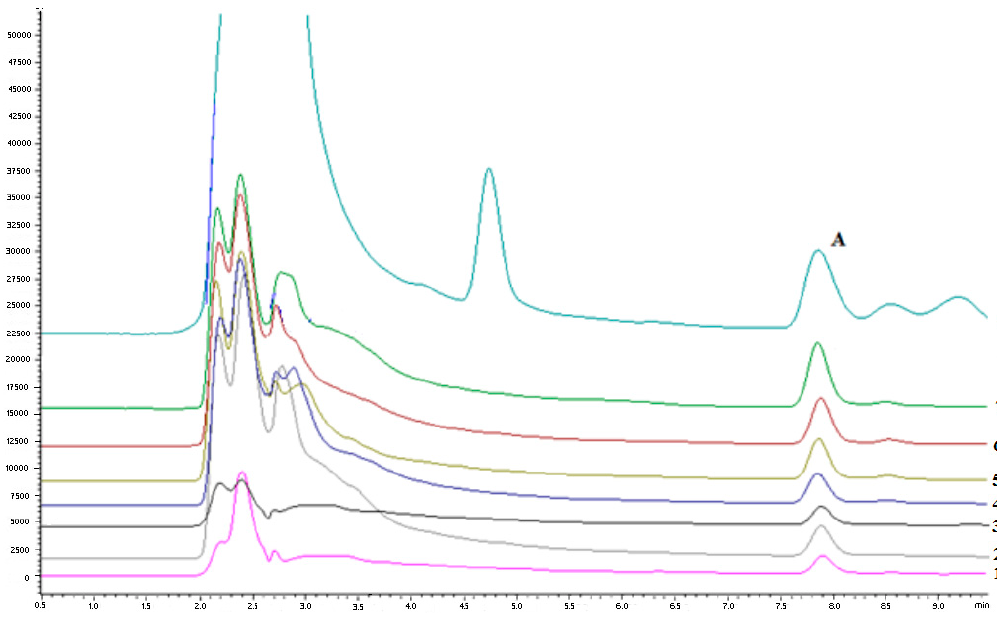
Figure 4. Chromatograms of samples analyzed by UPLC method. (1 standard of hederacoside C, 2–4 extracts, 5–7 capsules, 8 syrup) .